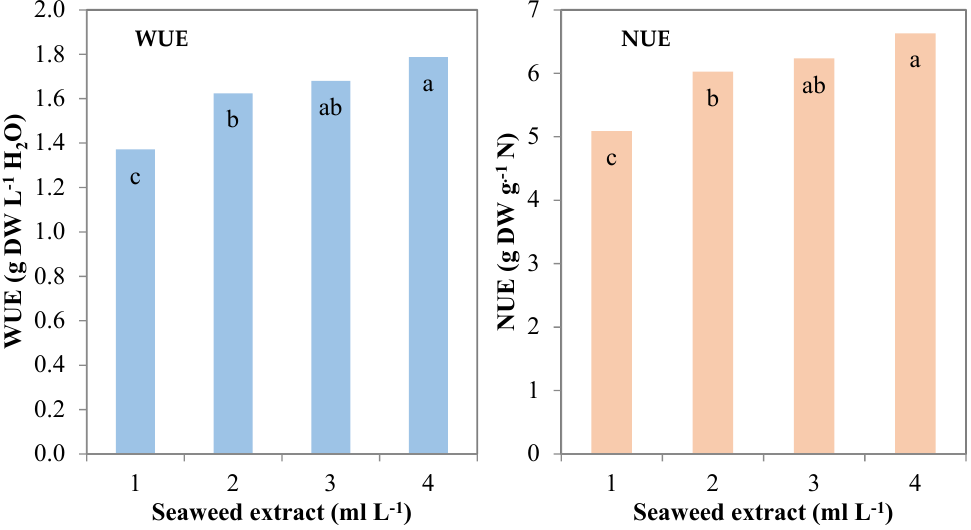
Figure 3. Water use efficiency (WUE) and nitrogen use efficiency (NUE) of leaf lettuce plants grown in nutrient solutions containing different concentrations of a seaweed extract from Ecklonia maxima (Bars of the same color with different letters are significantly different at p ≤ 0.05 according to Tukey’s test).